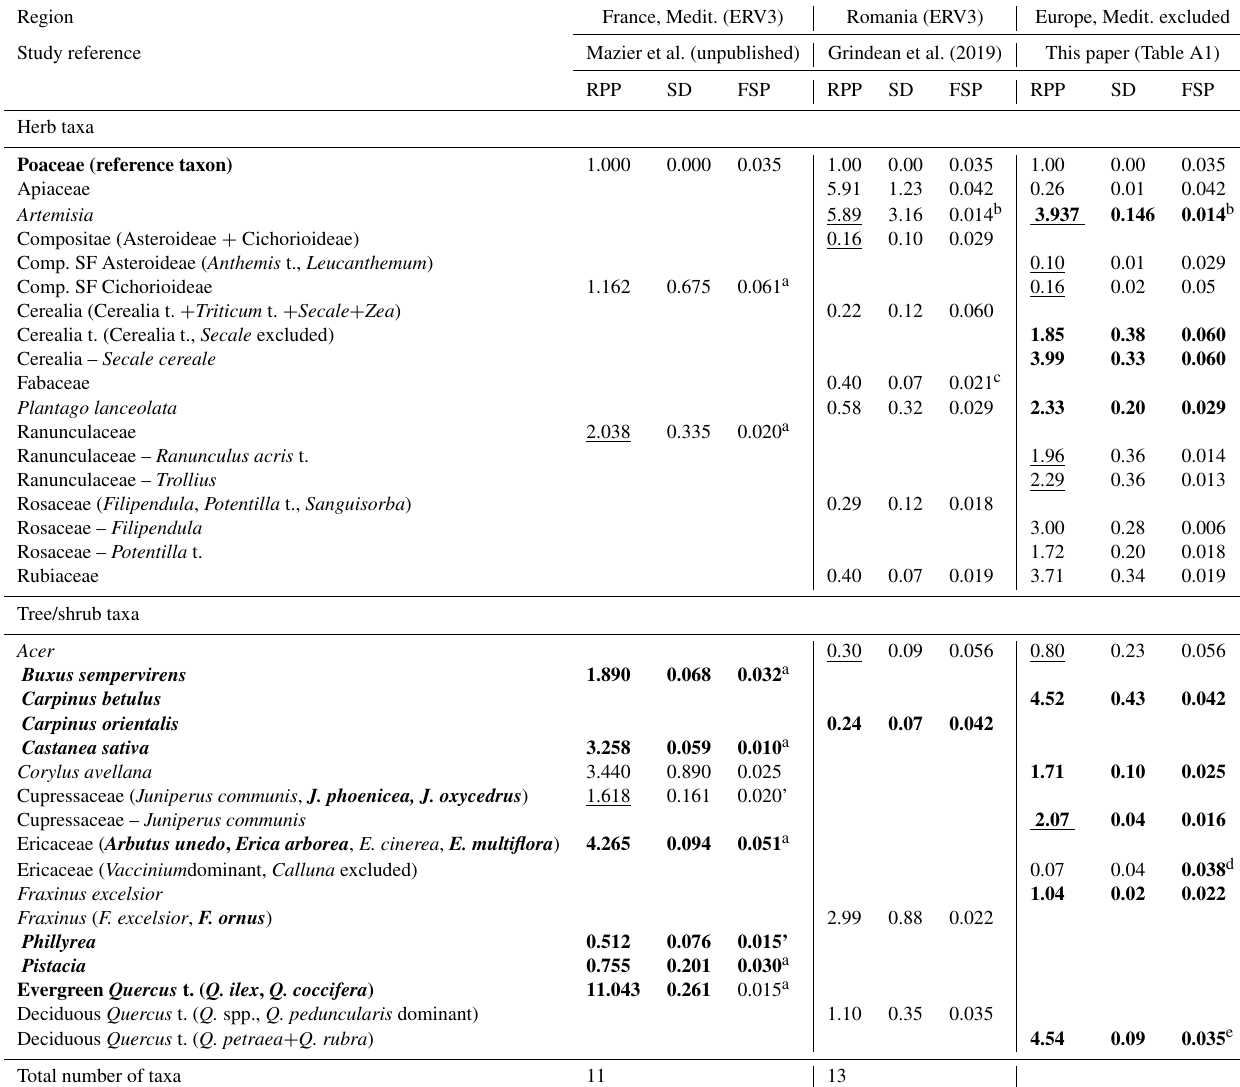
Table B2. Mediterranean area: RPP estimates and their SDs from two available studies and mean RPPs for northern and temperate Europe (Table A1, Appendix A) for comparison. RPPs and FSPs emphasized in bold are those used in the REVEALS reconstruction for Europe (this paper). The underlined values exhibit small differences between the Mediterranean study regions and/or between Mediterranean Europe and temperate–boreal Europe. FSP values: from Mazier et al. (2012) except a new values from Mazier et al. (unpublished), b value from Abraham and Kózaková (2012), and c value from Commerford et al. (2013). FSP from Mazier et al. (2012) used in the REVEALS reconstruction (this study) for Ericaceae (Medit.) d and evergreen Quercus t. e instead of the new FSP values from Mazier et al. (unpublished); for more explanations, see “Discussion” section in this paper. Abbreviations: Comp. – Compositae (Asteraceae), ERV 3 – extended R value model sub-model 3, Medit. – Mediterranean region, SF –